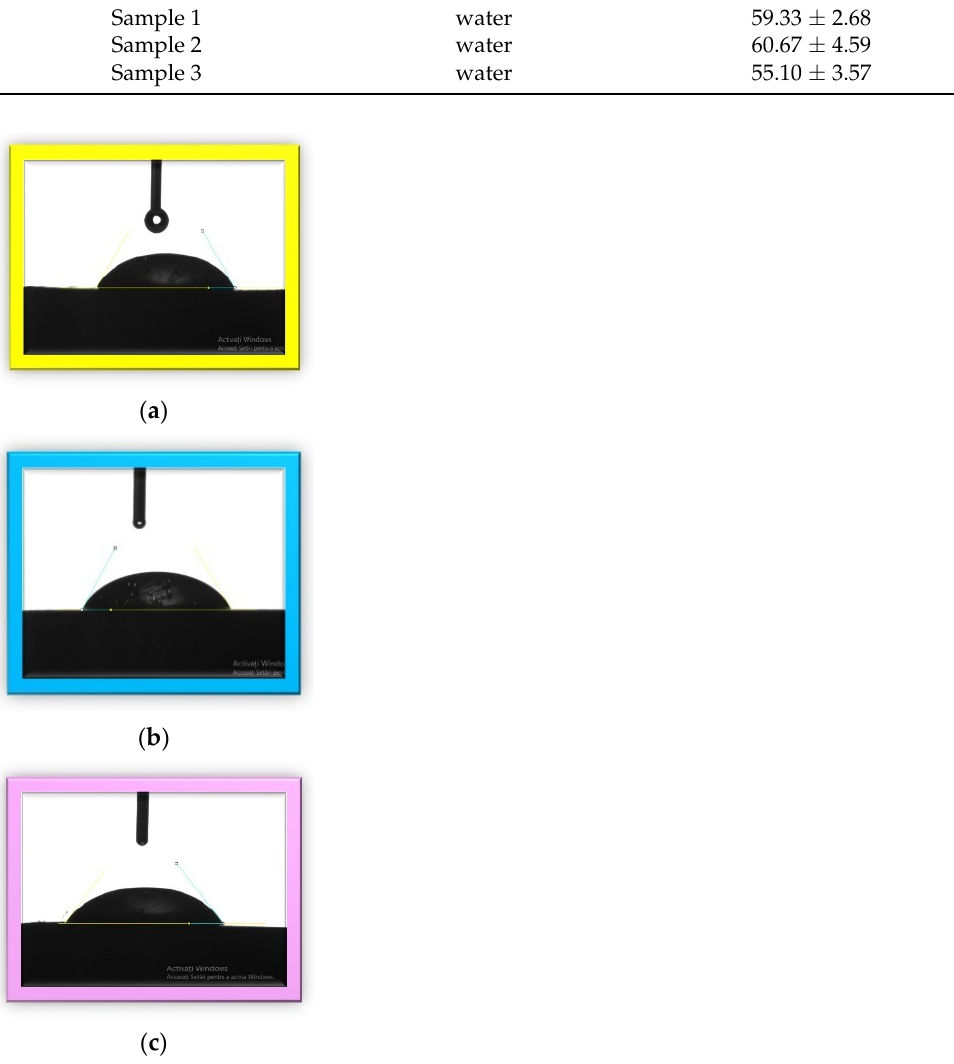
Figure 7. Images of liquid droplets on the surface of materials: ( a ) sample 1, ( b ) sample 2, ( c ) sample 3. Table 3. Contact angle values for the experimental samples.